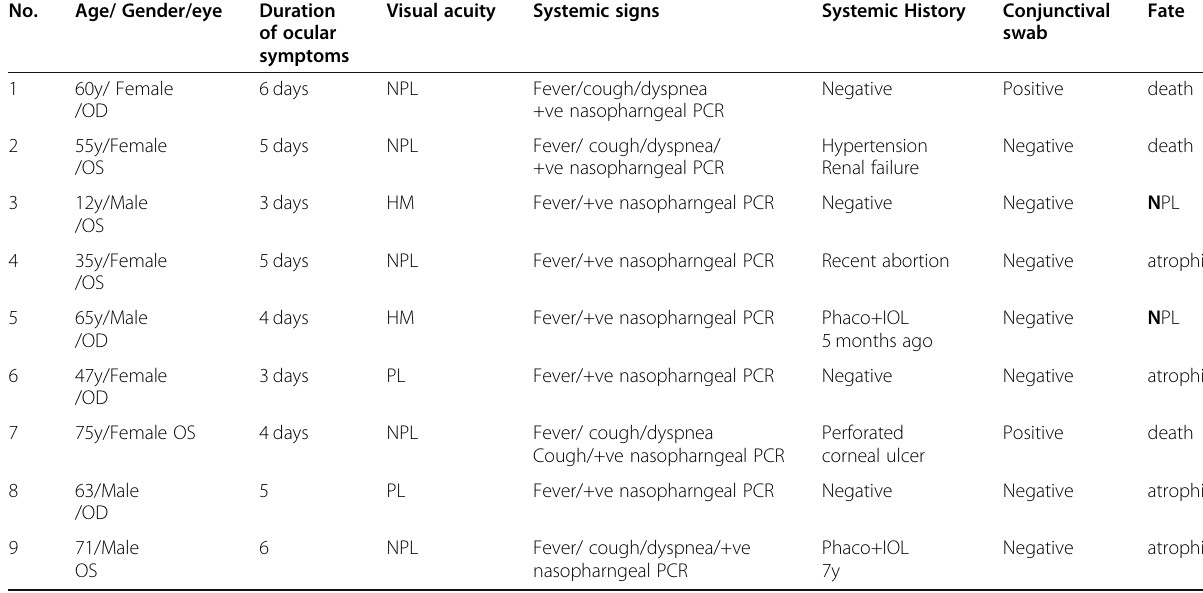
Table 1 Clinical data of the patients with combined endophthalmitis and orbital cellulitis